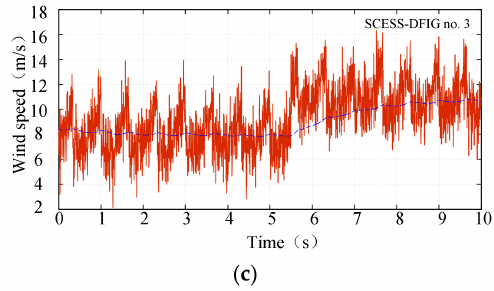
Figure 11. Wind speed curve given for SCESS-DFIG: ( a ) Wind speed curve given for SCESS-DFIG no. 1; ( b ) Wind speed curve given for SCESS-DFIG no. 2; ( c ) Wind speed curve given for SCESS-DFIG no.